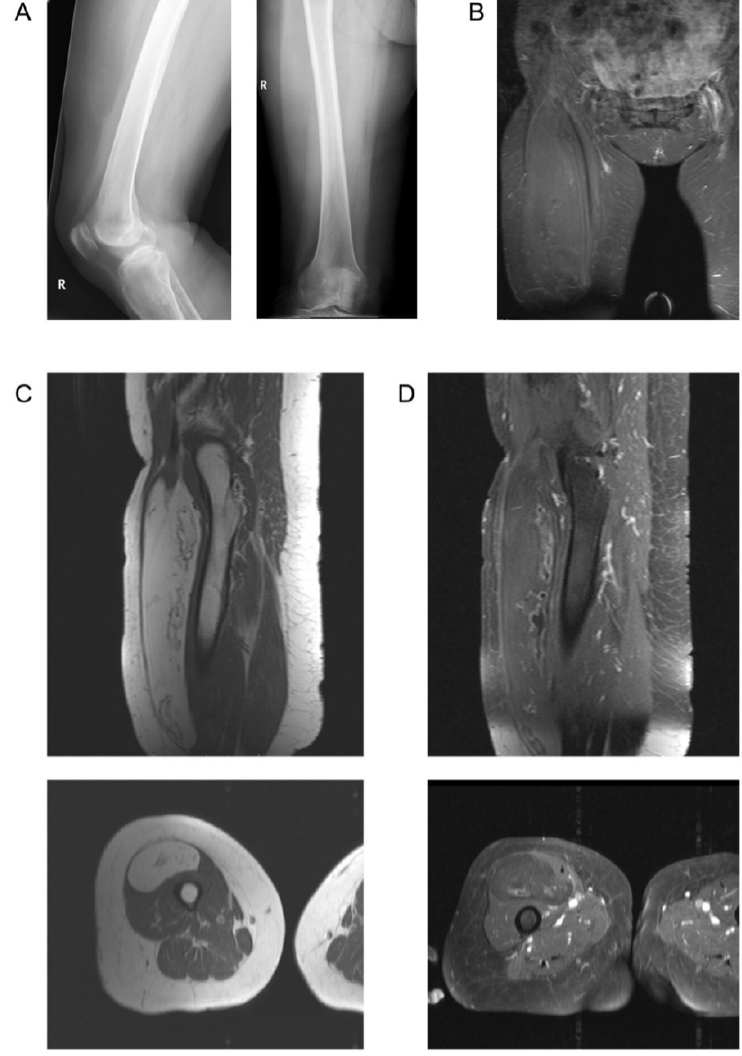
Figure 6. Images of a patient with low-grade liposarcoma (atypical lipomatous tumor) and an initial report describing lipoma. ( A ) X-Ray in lateral and a.p. view. ( B ) Coronal TIRM (STIR) sequence. ( C ) T1-weighted image precontrast in sagittal and axial plane. ( D ) T1-weighted image postcontrast with fat saturation .